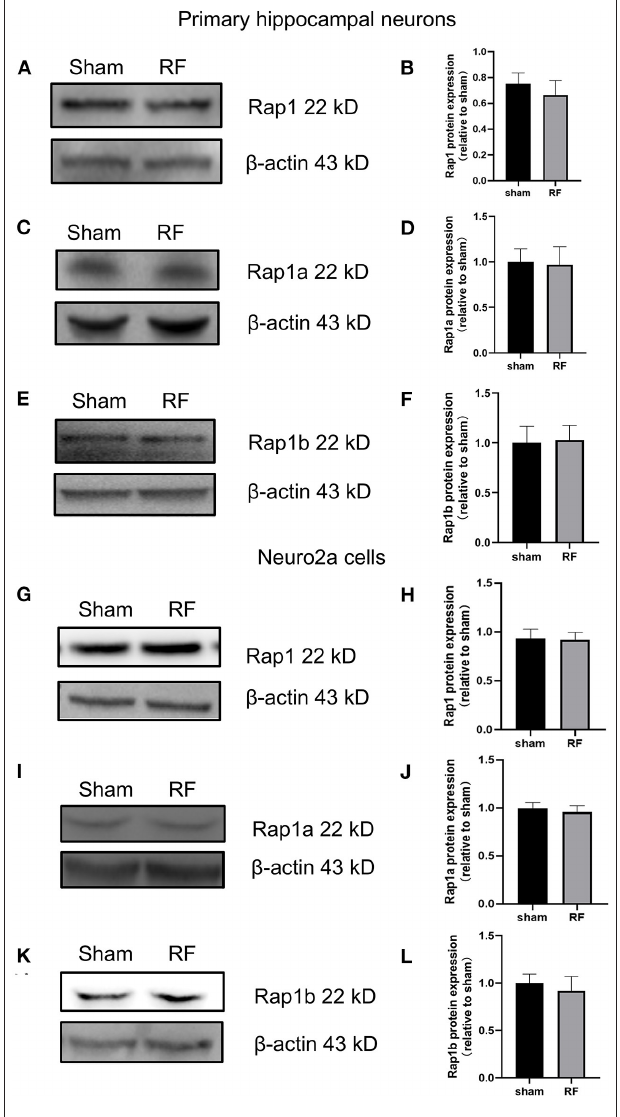
overexpressed Rap1-GTP by transfecting a constitutively active mutant Rap1 plasmid (Rap1-Gly_Val-GFP) into Neuro2a cells. Changing the 12th amino acid of the mutant plasmid from glycine to valine constitutively activates Rap1 (32, 33). After transfection of the constitutively active Rap1, its gene and protein expression levels increased in Neuro2a cells ( Supplementary Figure 2 ). After transfection of the mutant plasmid, the expression of Rap1-GTP increased after 48 h of irradiation ( Figure 7 ). Overexpression of Rap1-GTP reversed the disturbance of neurite outgrowth induced by 48 h of RF-EMR exposure ( Figure 8